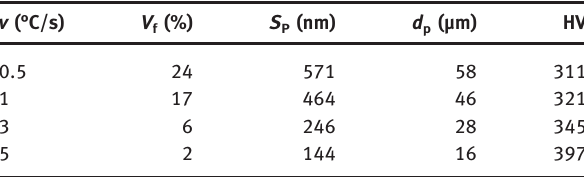
Table 1: The results of quantitative metallography.